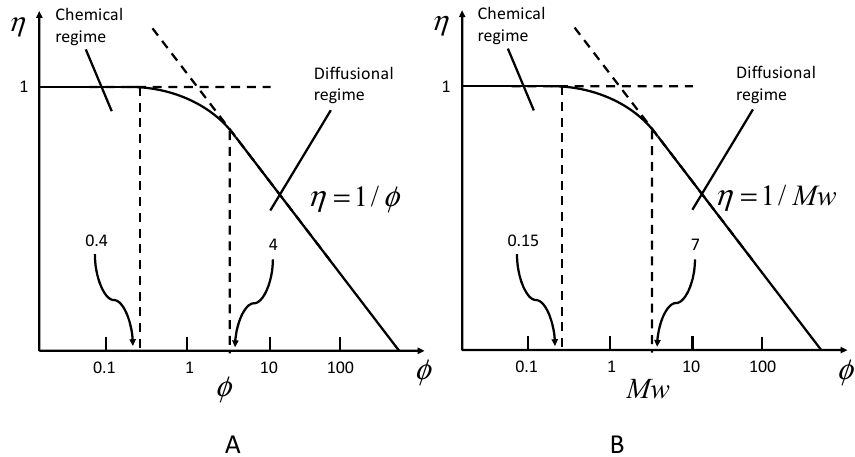
Figure 5. ( A ) Relationship between effectiveness factor and Thiele modulus; ( B ) relationship between effectiveness factor and Weisz modulus. Re-elaborated from Santacesaria [20] with the permission of Elsevier-Catalysis Today 1997.